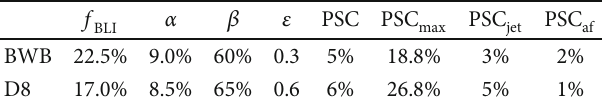
Figure 11: Sensitivity of C _ position of TP. The values of calculated dissipation components are normalized by near- fi eld drag coe ffi cient C D . Table 5: Comparison of PSC for the BWB aircraft and D8